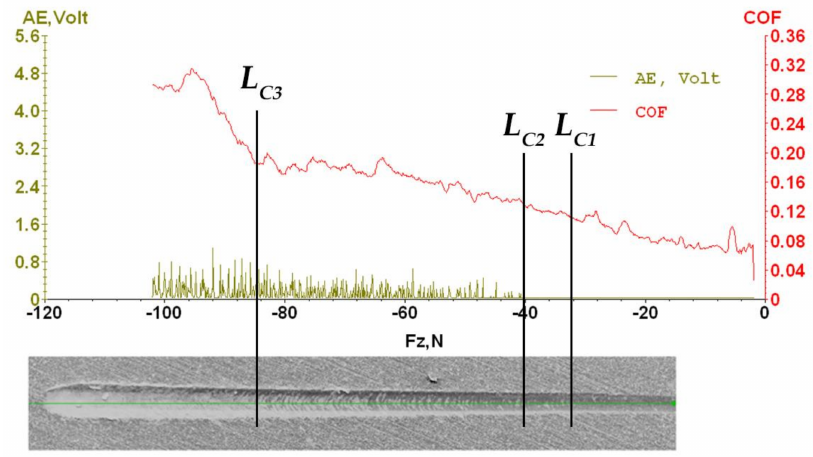
Figure 8. The record of the Micro-Scratch test and scratch track; AE–Fz, COF–Fz (AE—acoustic emission, COF—coefficient of friction, Fz—normal